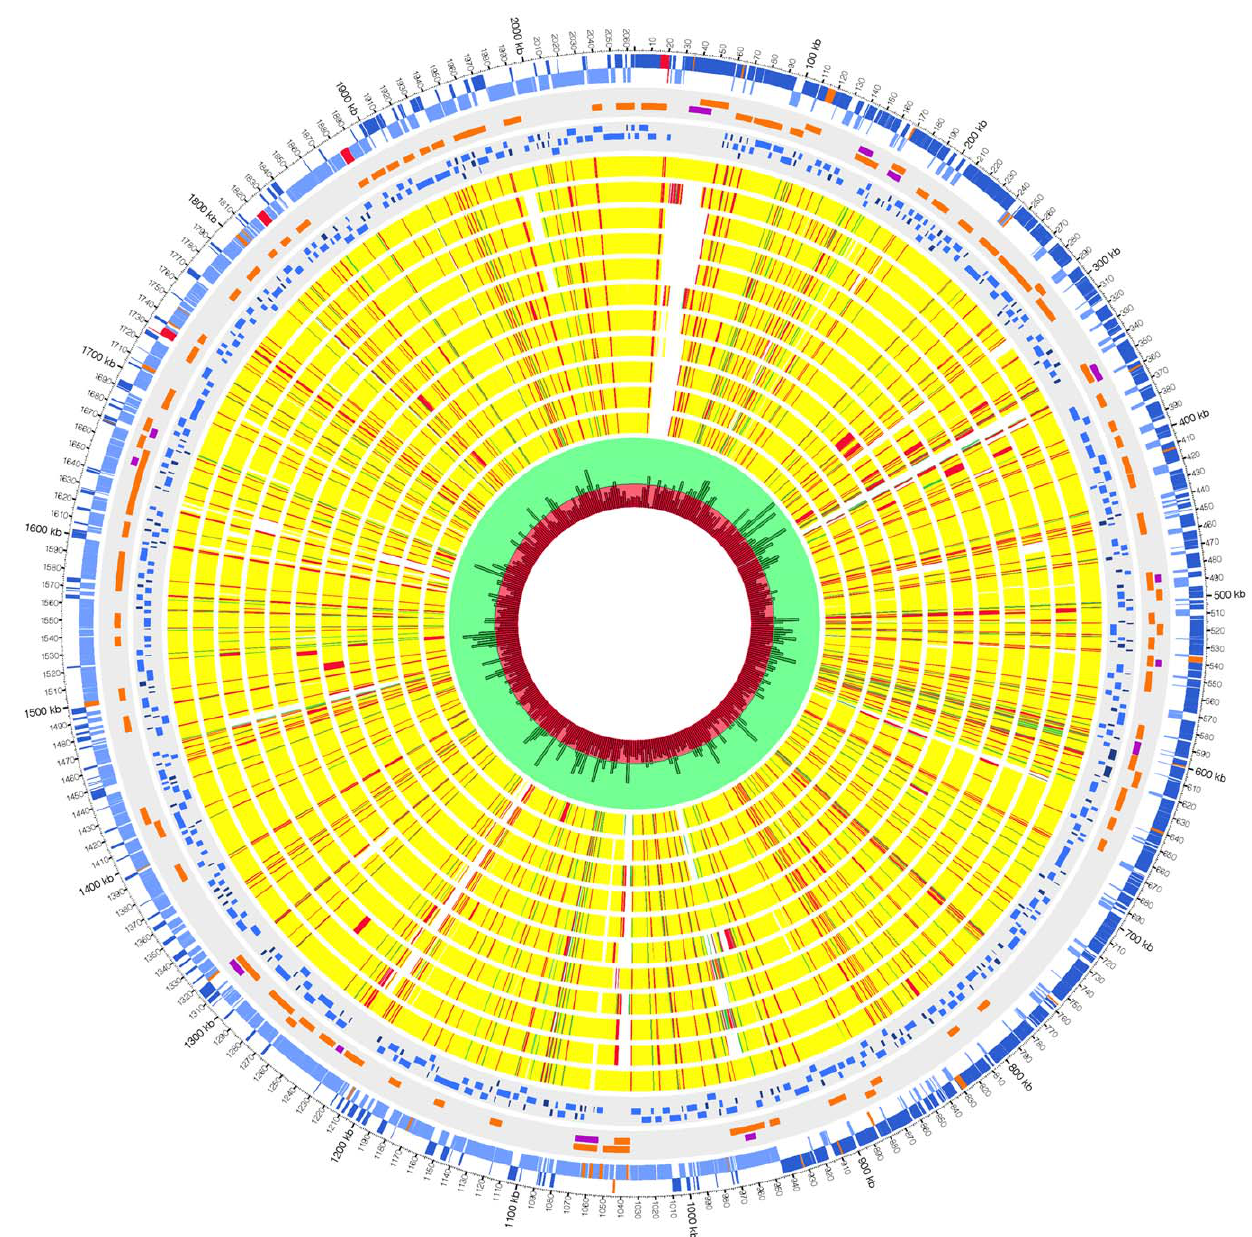
Figure 2. Graphical representation of the chromosome of S.pneumoniae PNI0373. Starting at the outermost circle moving to innermost, the circles display the following features. Circles 1 and 2 show forward and reverse strand genes, respectively (blue: coding, orange: pseudogenes, red: structural RNAs). Genomic regions displaying evidence of horizontal gene transfer are shown in circle 3 (orange: AlienHunter and purple: Islandviewer including SIGI-HMM, IslandPick and IslandPath_DIMOB). The fourth circle outlines the location and organization of pneumococcal core genes (dark blue: core gene singletons and light blue: syntenic blocks of 2 or more core genes. Circles 5 through 15 are BLASTN comparisons of other complete pneumococcal genomes to PNI0373 in following order: P1031, 70585, CGSP14, D39, G54, Hungary 19A-6, JJA, ATCC 700669, R6, Taiwan 19F-14 and TIGR4 with yellow showing high similarity (95–100%), red for intermediate (85–94%) and green for low (75–85%). The innermost circle displays the density per 5000 bp of the cumulative SNPs detected by comparison of 11 pneumococcal genomes to in PNI0373 (red shaded area: SNP density of 115 SNP per 5000 bp or less and green shaded area: SNP density between 115 and 345 SNPs per 5000 bp).